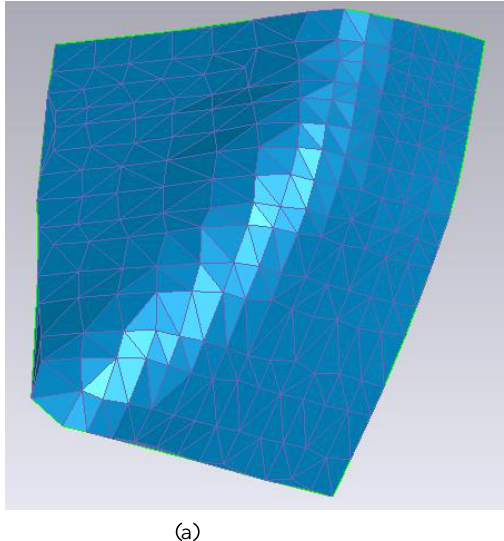
Figure 3. (a) is the template and (b) is the search surface.